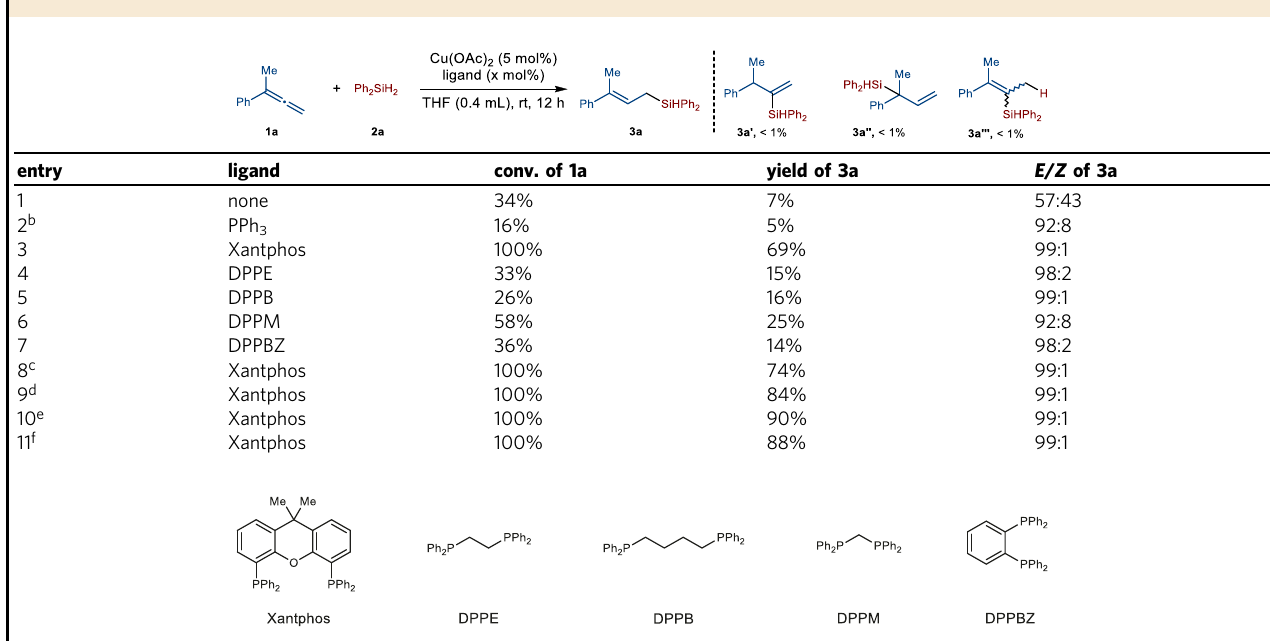
Table 1 Reaction